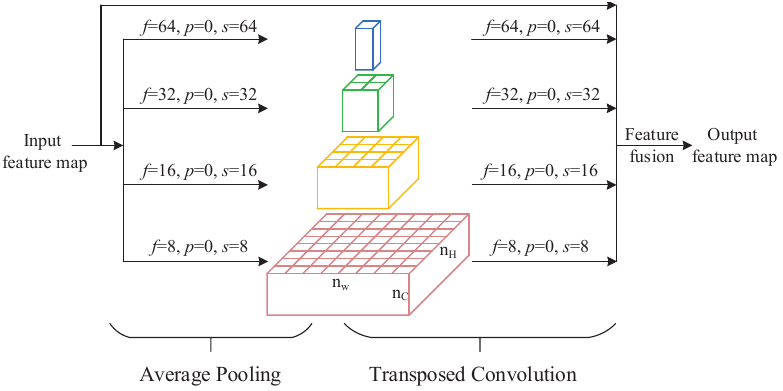
Figure 8. Pyramid pooling